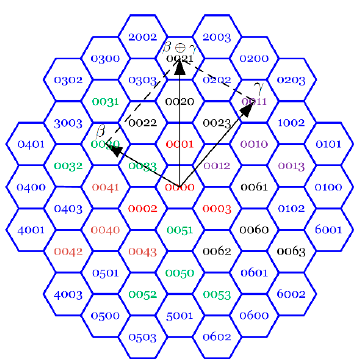
Figure 3. An example of a coding addition operator.